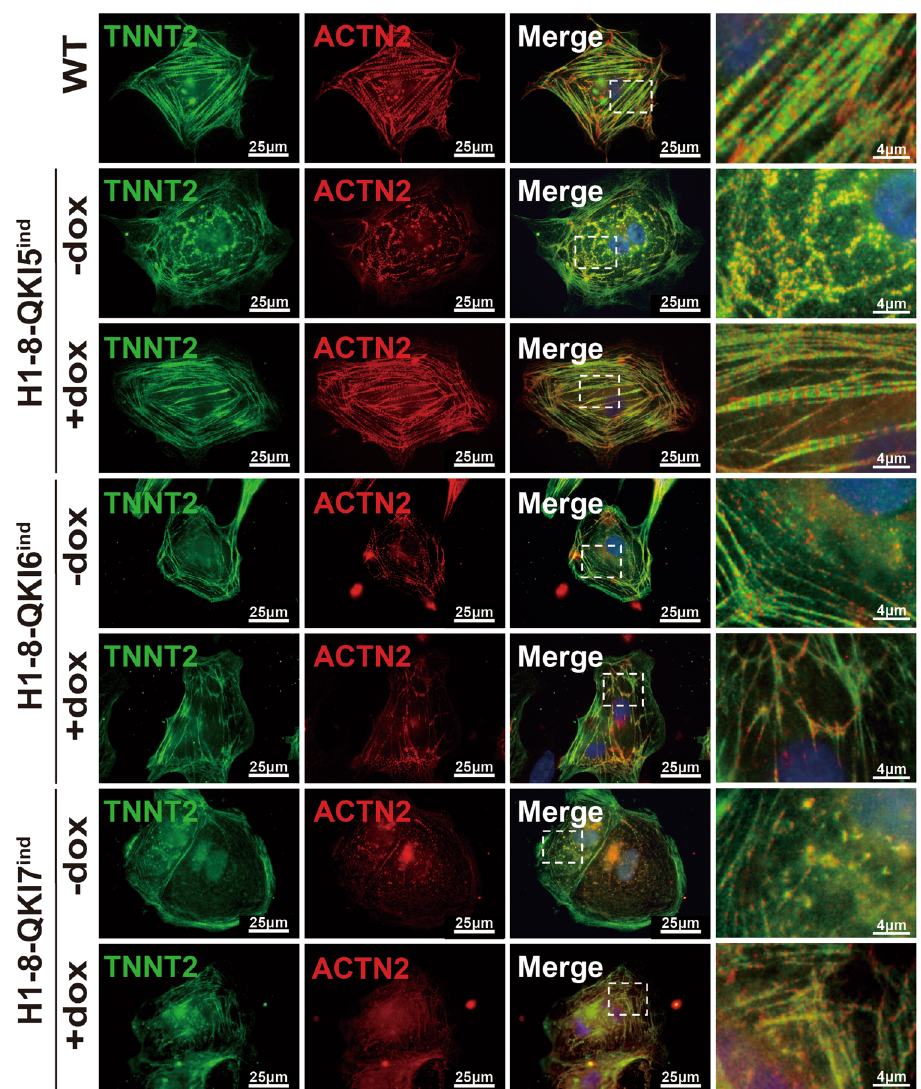
Fig. 8 Reactivation of QKI5 in hESCs- QKI del rescues myo fi brillogenesis. Inducible QKI5, QKI6, and QKI7 expression cells are established in H1-8 lines (H1-8- QKI5 ind , H1-8- QKI6 ind , H1-8- QKI7 ind ). Representative images of immuno fl uorescence staining of TNNT2 and ACTN2 in H1-8- QKI5 ind , H1-8- QKI6 ind , H1-8- QKI7 ind cardiomyocytes with or without doxycycline induction. Myo fi brillar structures are recovered in doxycycline-induced H1-8- QKI5 ind cardiomyocytes (Day-15) and ACTN2 expression is also recovered. However, doxycycline-induced H1-8- QKI6 ind and H1-8- QKI7 ind cardiomyocytes fail to recover ACTN2 expression and generate normal myo fi brillar structures (Day-15). Scale bar: 25 μ m. All experiments are independently repeated three times with three different sets of cell samples to con fi rm the reproducibility of the fi cardiomyocytes, which was consistent with the temporal expression homozygous mutant embryos, which died in utero at E10.5 pattern of QKI in the hESC-CM differentiation system and in (Fig. 9A). 53 Histological analysis of E9.0-9.5 embryonic hearts mouse cardiovascular development. However, similar reactivation of demonstrated a thin ventricular wall with a signi fi cantly reduced QKI-6 and QKI-7 expression in hESCs- QKI del failed to rescue the level of trabeculation in Qki β Geo/ β Geo homozygous mutants rela- abnormal contractile phenotypes at both the functional and cellular tive to the level seen in the hearts of wild-type littermate or levels (Fig. 8 and Supplementary Movies 7 – 10). The lack of striated Qki β Geo/ + heterozygous embryos (Fig. 9B). Qki β Geo/ β Geo mutant myo fi bril structures and the lack of a normal form of ACTN2 in hearts had similar downregulation of sarcomere genes (Fig. 9C hCMs- QKI del : QKI-6 ind and hCMs- QKI del : QKI-7 ind con fi rmed that and Supplementary Fig. 12A), which was consistent with the the nuclear QKI-5 was the functional QKI isoform regulating the fi ndings demonstrated by hCM- QKI del scRNA-seq and bulk alternative splicing in developing cardiomyocytes. Collectively, these RNA-seq data. Dual-immuno fl uorescence staining using anti- fi ndings also suggested that QKI-6- and QKI-7-mediated activity in bodies against cardiac α -actinin ( Actn2 ) and troponin I ( Tnni3 ) regulating RNA stability, post-transcriptional modi fi cation, or demonstrated dramatically reduced expression levels of Actn2 transportation were not essential to the cardiac myo fi brillogenesis. and a signi fi cant defect in myo fi brillogenesis in Qki β Geo/ β Geo hearts (Fig. 9D), which closely resembled the defect seen in hCMs- QKI del . As we tested so far, all altered alternative splicing events in Qki β Geo/ β Geo mutants were identical to that found in the above observations in vivo, we analyzed Qki β Geo/ β Geo